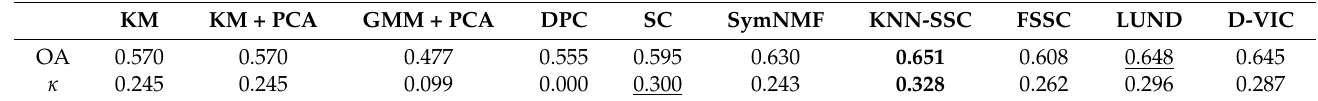
Table 4. Performances of D-VIC and related algorithms on the Madingley HSI. The highest and second- highest performances are bolded and underlined, respectively. Many graph-based algorithms—SC, KNN-SSC, LUND, and D-VIC—achieved approximately the same high performance on the Madingley HSI, indicating that graph-based HSI clustering algorithms may be used for unsupervised ash dieback disease mapping, even when no ground truth labels exist. KM denotes K -Means.